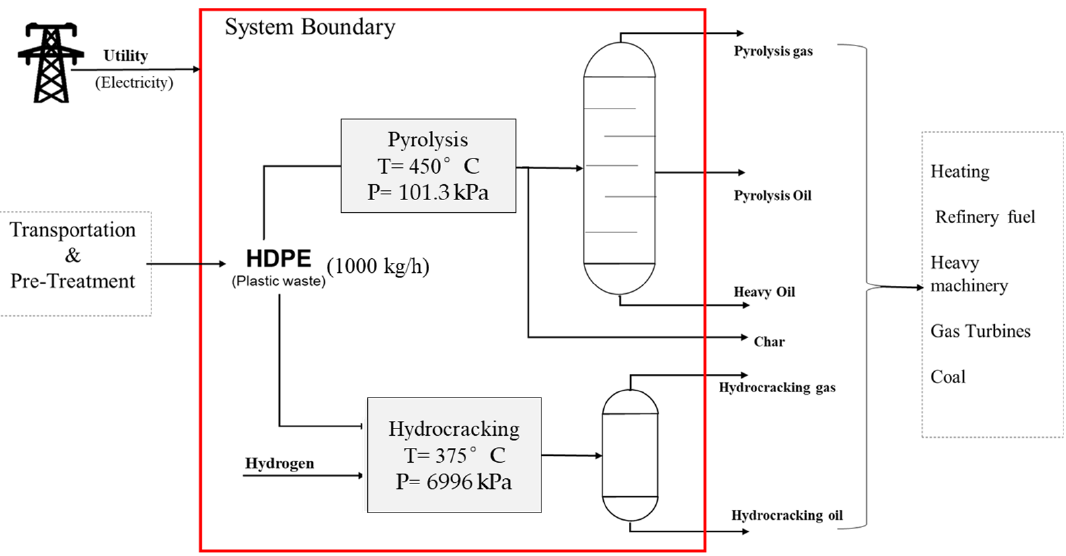
Figure 18. System boundary for the lifecycle assessment of pyrolysis and hydrocracking scenarios.